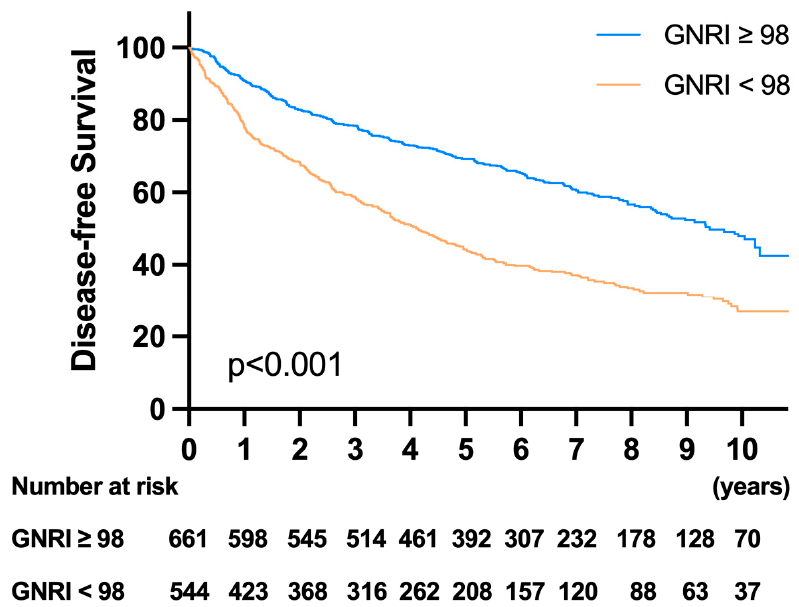
Figure 4. Kaplan–Meier survival analysis of disease-free survival (DFS) according to the GNRI. Patients with GNRI < 98 had significantly worse survival than those with GNRI ≥ 98. Table 6. Univariate and multivariate analysis of prognostic factors for DFS in patients with CRC undergoing a curative resection.